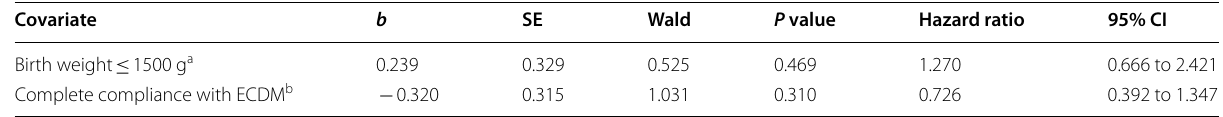
Table 6 Cox proportional hazard regression analysis for the relationship between survival time and compliance with echocardiography‑directed management protocol as adjusted for birth weight